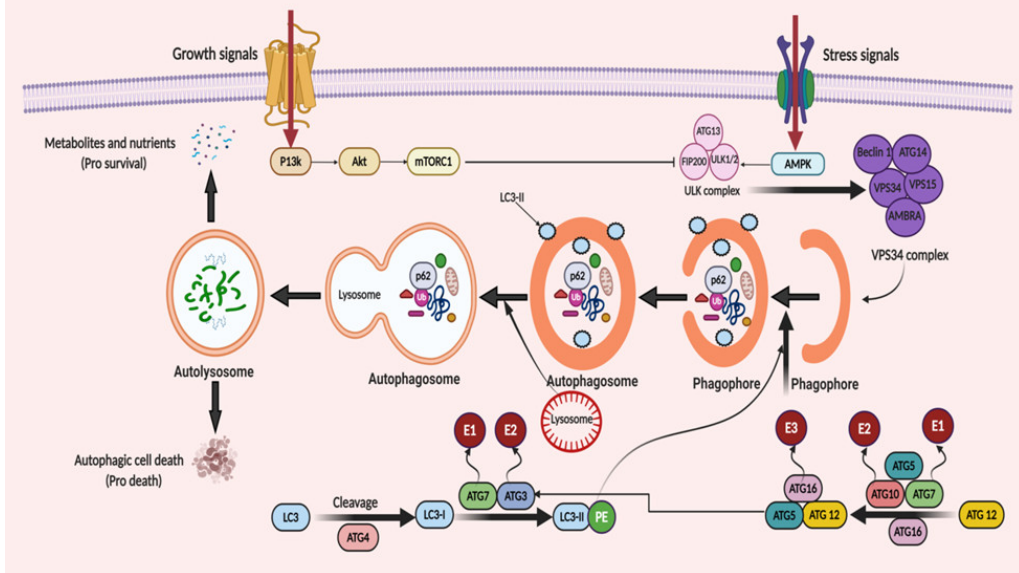
Figure 2. When cellular energy is sufficient, mammalian target of rapamycin complex 1 (mTORC1) becomes activated and phosphorylates each member of the ULK complex to prevent autophagy induction. In the case of glucose absence or cellular stress conditions, AMP-activated protein kinase (AMPK) becomes activated to initiate autophagic flux. This flux starts with the formation of the ULK complex consisting of ATG13, ULK1/2 and FIP200 (a ULK-interacting protein). The activity of mTORC1 is prohibited, non-phosphorylated ATG13, ULK1/2 and FIP200 forms a complex and, as a result, autophagy is started. The initiation of phagophore formation is achieved with the gathering of the ATG14, Beclin 1, VPS34, VPS15, and AMBRA proteins to generate the VPS34 complex. This also affects the further continuation of autophagic activity with downstream constituents. This takes place with the help of two ubiquitin-like conjugation systems. The first system comprises of ATG12 protein binding. Firstly, ATG7, which is linked to ubiquitin-activating enzyme E1, activates ATG12. Then, with the conjugation of ATG10 linked to ubiquitin-activating enzyme E2, ATG5 and ATG16, a huge protein complex is formed to contribute to the progression of the autophagosome. Similarly, in the second system, with the help of ATG4 protein, LC3 is modified to LC3-I. Then, LC3-I is attached to phosphatidylethanolamine (PE) to form LC3-II-PE catalyzed by ATG7 linked to E1, and ATG3 linked to E2. LC3-II-PE binds the membrane surface of the autophagosome and helps the attachment of adaptor proteins. When the phagophore formation is completed, it is named as a mature autophagosome. After fusion of the lysosome and autophagosome, an autolysosome is formed and it leads the degradation of the materials, recycles the nutrients and metabolites to supply energy (pro-survival) and triggers the autophagic cell death (pro-death).